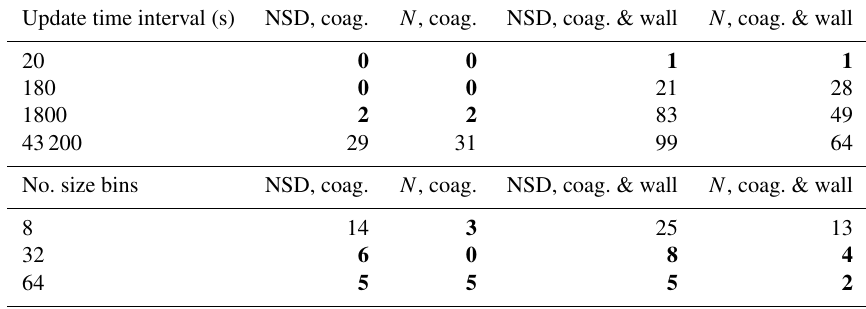
Table 2. Percent deviation from the high-resolution reference case for the seed without partitioning (non-volatile particles in the absence of vapours) scenario for number size distribution (NSD) (Eq. 19) and total particle number concentration ( N ) (Eq. 20). The top section of the table shows sensitivity to temporal resolution (update time interval) using 128 size bins, whilst the bottom section shows sensitivity to size bin number (number of size bins) using a 60s update time interval. Columns headed “coag.” are for simulations wherein coagulation acts alone, whilst columns headed “coag. and wall” are for simulations with both coagulation and particle loss to walls.